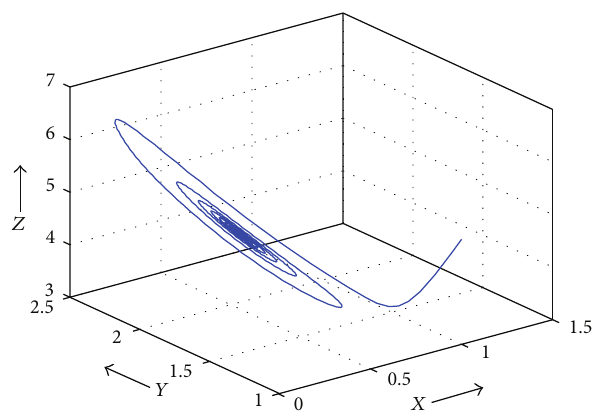
Figure 7: 𝑋𝑌𝑍 -plane projection of the solution for nonzero exoge- nous input ( 𝛾 = 1.25 ) with 𝑋(0) = 1 , 𝑌(0) = 1 , and 𝑍(0) = 5 ; parameter values are given in Table 1.